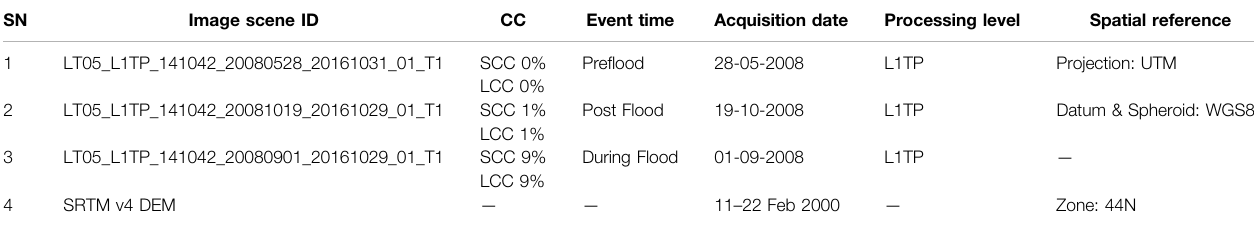
TABLE 1 | Satellite and DEM data characteristic details used in the study.